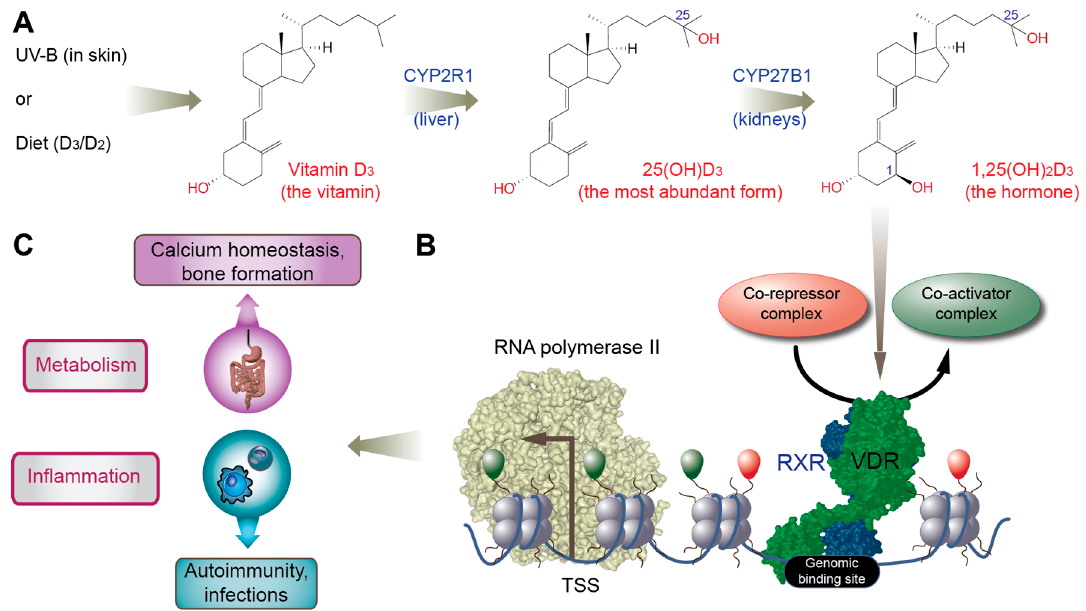
Figure 2. Gene regulation by vitamin D and its physiological impact. Vitamin D 3 , produced endogenously in skin or taken up by diet or supplementation, is converted in the liver into 25(OH)D 3 and then in the kidneys into the high-affinity vitamin D receptor (VDR) ligand 1,25(OH) 2 D 3 ( A ). Ligand-activated VDR binds genome-wide to some 5–20,000 sites within accessible chromatin ( B ). Some of these epigenome-wide effects translate into the changes of the transcriptome, i.e., the activation (or repression) of vitamin D target genes. The main physiological processes regulated by these genes are cellular metabolism, such as calcium homeostasis important for bone formation, and the regulation of innate and adaptive immunity, such as improving the response to infectious microbes, reducing chronic inflammation and preventing autoimmune disease ( C ).